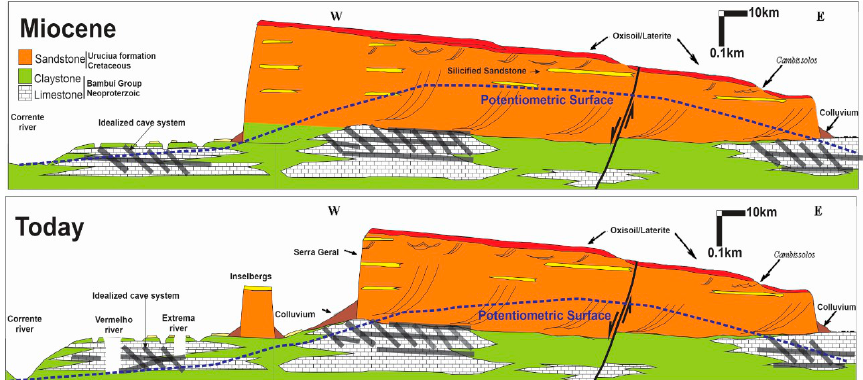
Figure 4. Conceptual model describing the formation of caves in the region. The cross-section of the landscape in the area formed by the retraction of the escarpment of Cretaceous sandstone from Urucuia formation, over Proterozoic carbonates and claystone from the Lagoa do Jacaré Formation of Bambu í group. The dotted blue line is the position of potentiometric surface, thick black lines are the positions of caves and yellow spots are silicified sandstone. Based upon